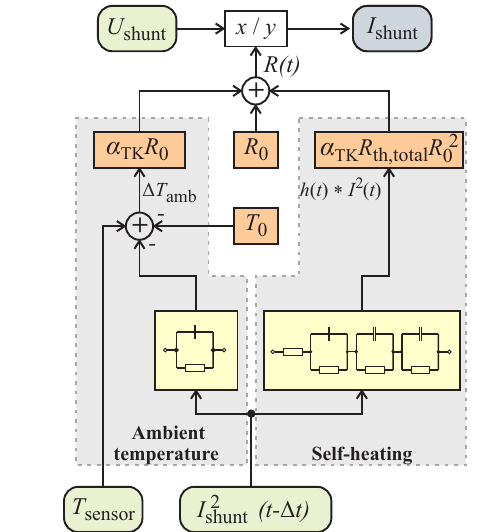
Figure 4. Overall dynamic correction algorithm, taking into ac- count effects due to self-heating and ambient temperature